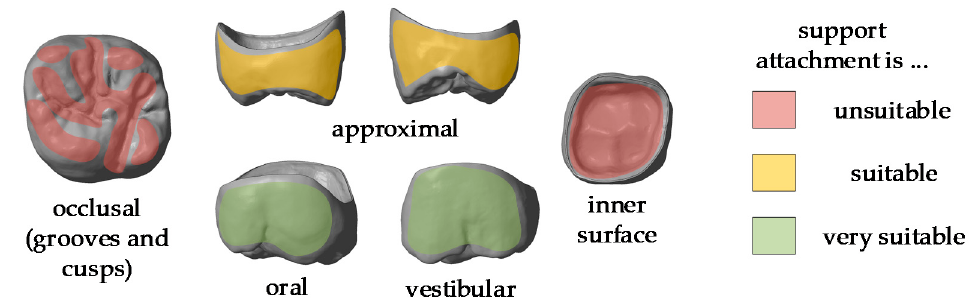
Figure 3. stl-file of a molar crown with marking the different areas of support attachment.